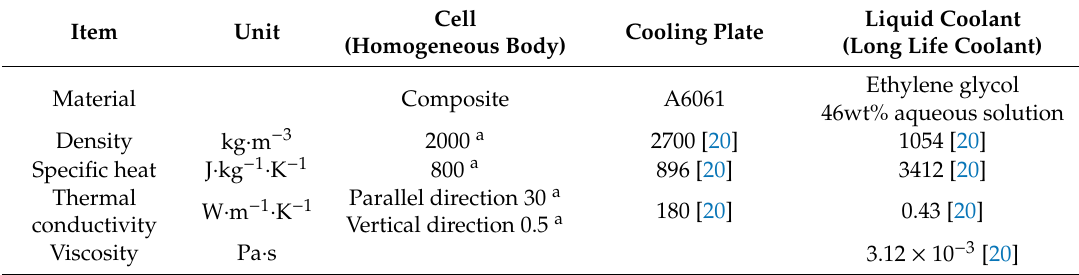
Table 2. The physical properties using the simulations. Superscript “a” indicates the assumed value. Cell Liquid Coolant Item Unit Cooling Plate (Homogeneous Body) (Long Life Coolant) Ethylene glycol Material Composite A6061 46wt% aqueous solution Density kg · m − 3 2000 a 2700 [20] 1054 [20] Specific heat J · kg − 1 · K − 1 800 a 896 [20] 3412 [20] Thermal Parallel direction 30 a 180 [20] 0.43 [20] W · m − 1 · K − 1 conductivity Vertical direction 0.5 a Viscosity Pa · s 3.12 × 10 − 3 [20] The charging or discharging conditions for the battery pack are the same as the